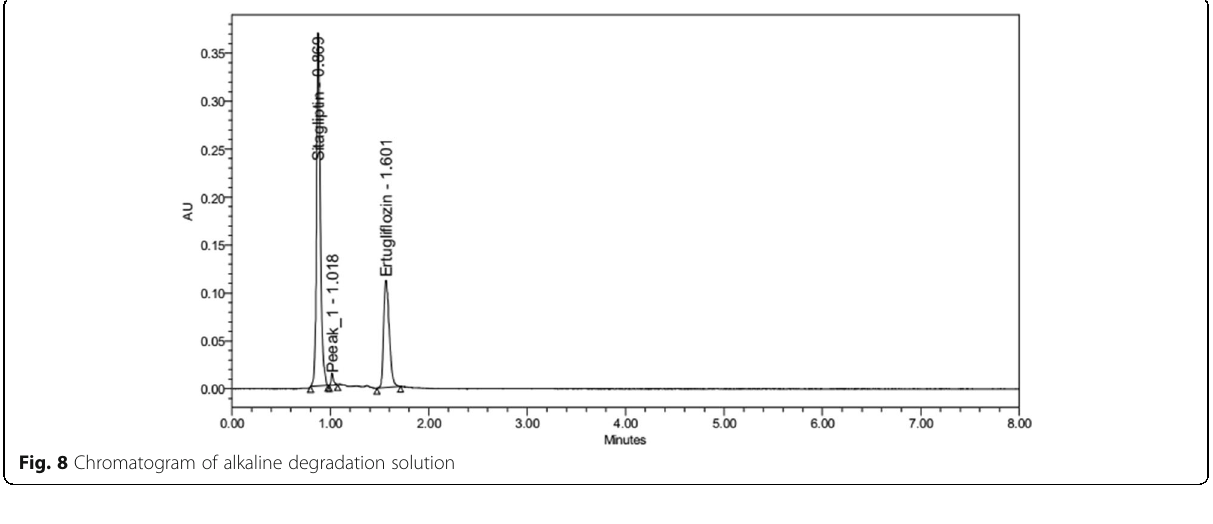
Fig. 8 Chromatogram of alkaline degradation solution